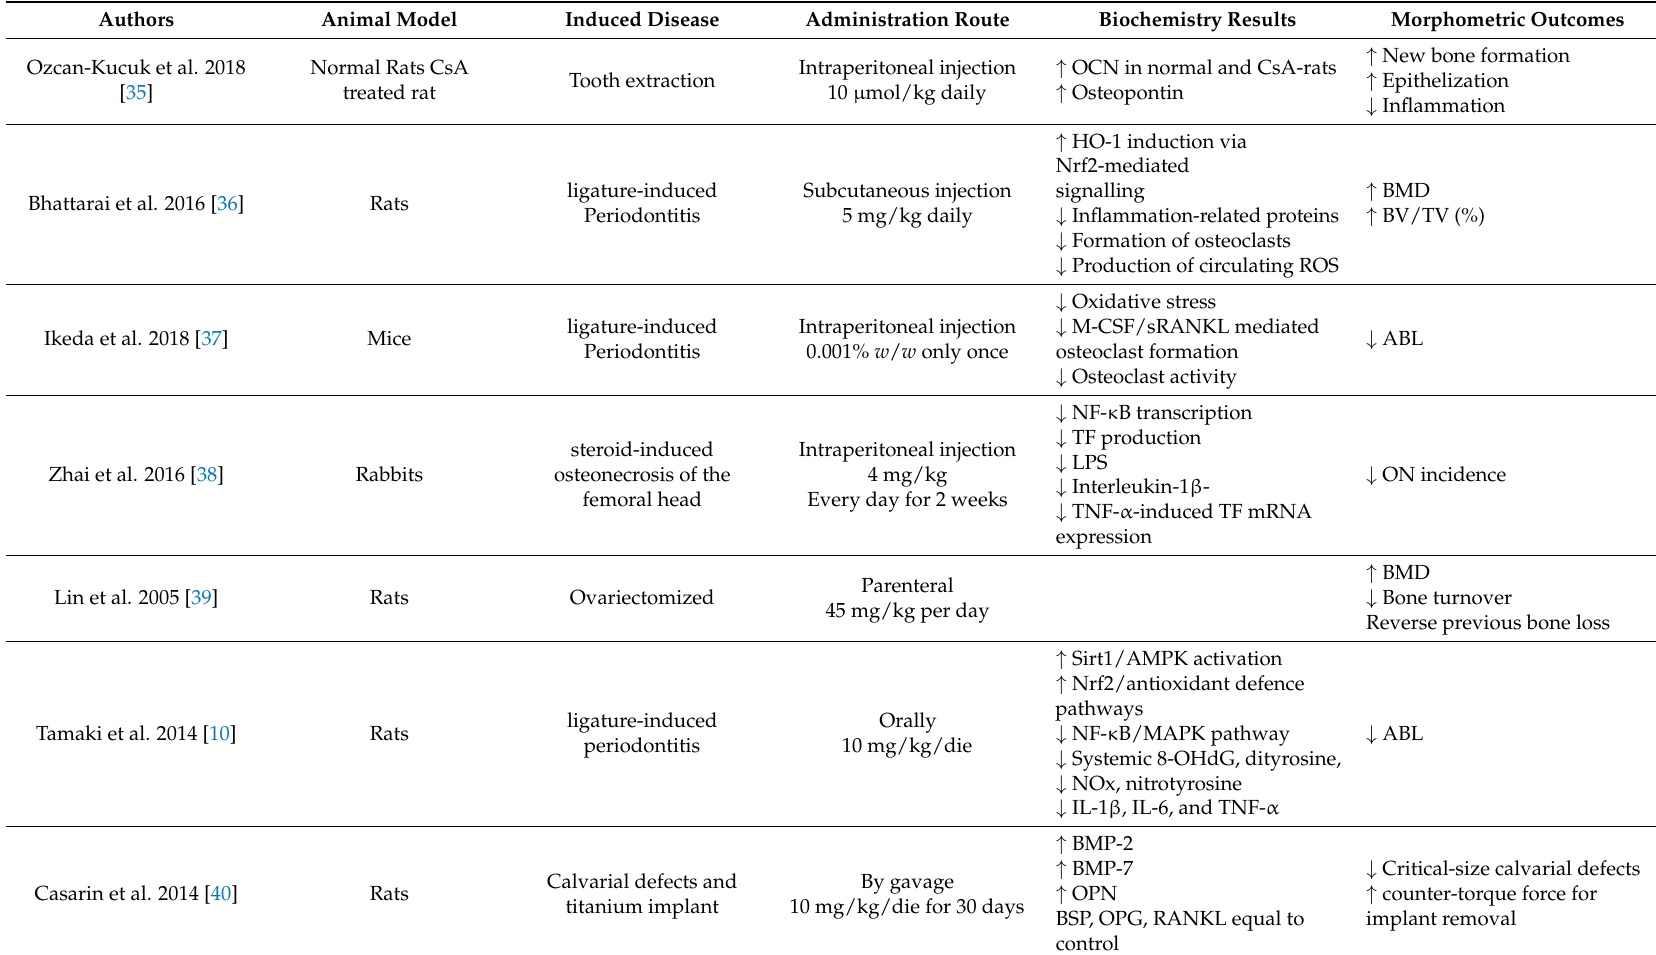
Table 2. Summary of Resveratrol’s in vivo